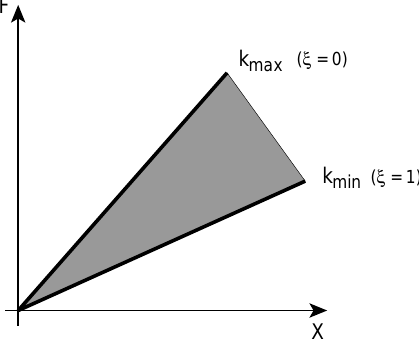
Fig. 5. The stiffness of the SMA wire changes as a result of phase